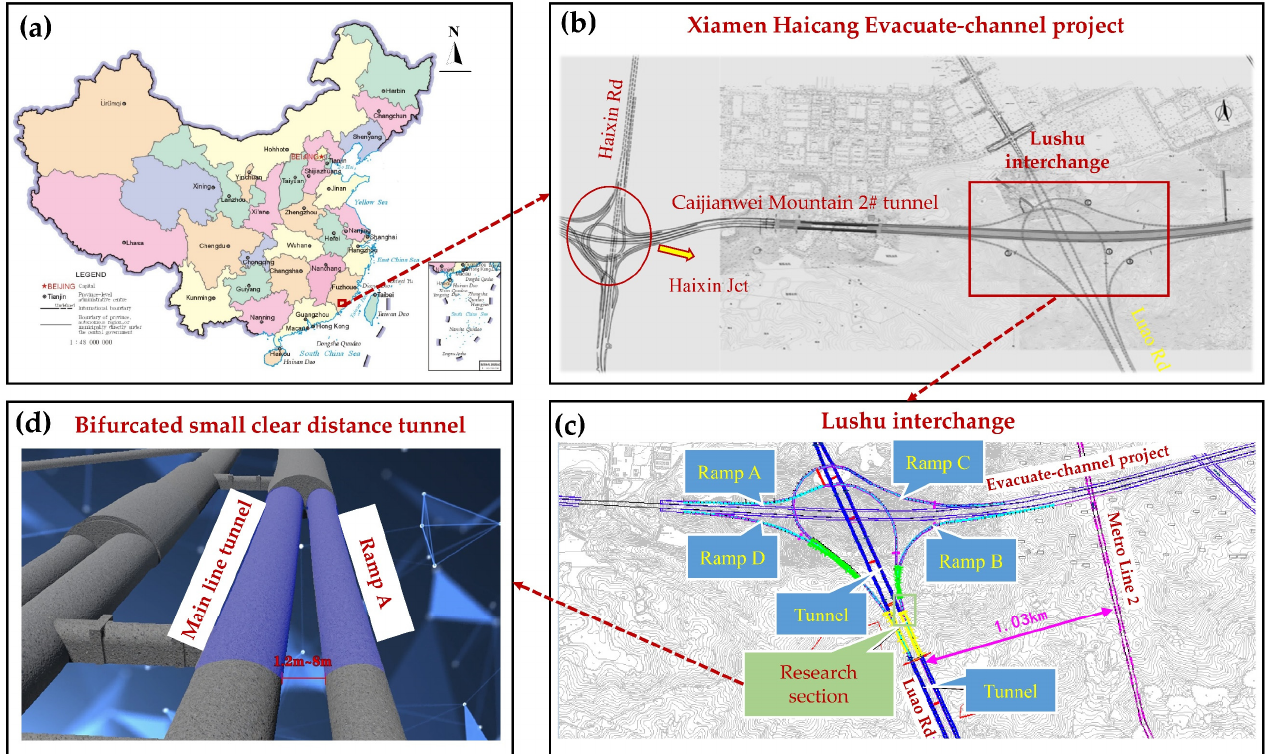
Figure 1. Research section diagram: ( a ) location of Xiamen Haicang; ( b ) location of Xiamen Haicang Evacuate Channel project; ( c ) diagram of Lushu interchange; and ( d ) schematic of research section.